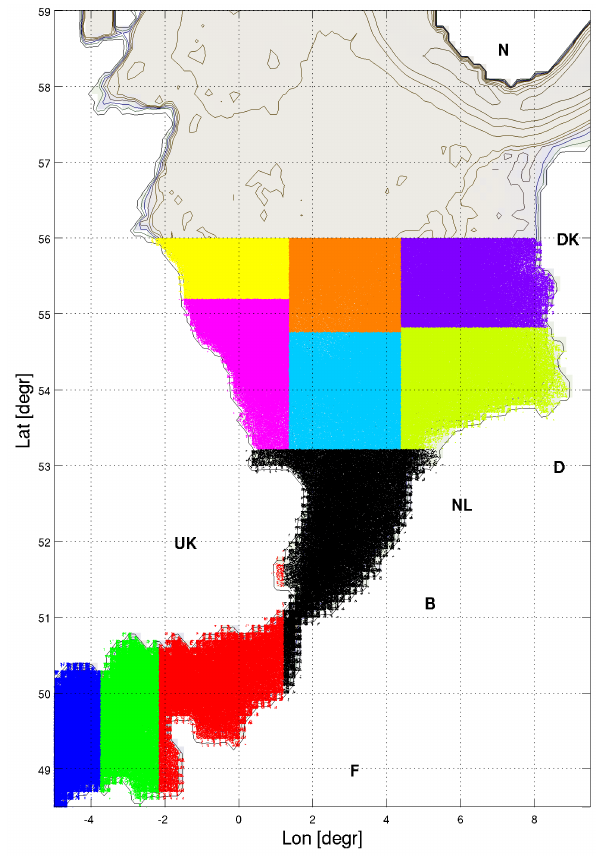
Figure 2. Release distribution of particles for the numerical runs. Colour of the dots solely indicates the release